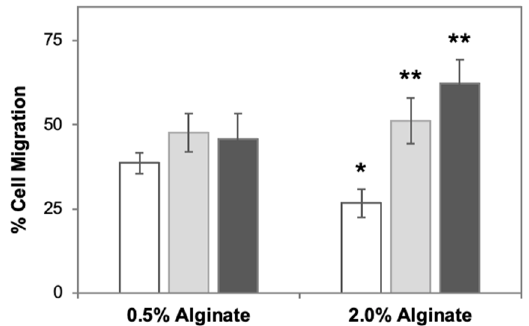
Figure 2. Migration of U87 cells into 0.5% and 2% alginate gels containing different ratios of RGD-modified and unmodified alginate—1:3 (white), 1:1 (light grey), and 3:1 (dark grey)—after three days. Error bars represent the standard deviation of three biological samples. Statistical significance was independently evaluated for alginate gels containing different ratios of RGD-modified and unmodified alginate relative to unmodified alginate gels using a two-tailed t -test evaluated with a 95% (*) or 99% (**) confidence interval.